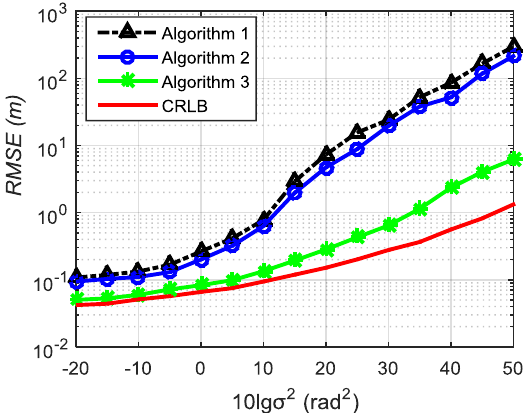
Figure 4. RMSE curve change with the orientation angle-measurement error for different algorithms at SNR = 0 dB.